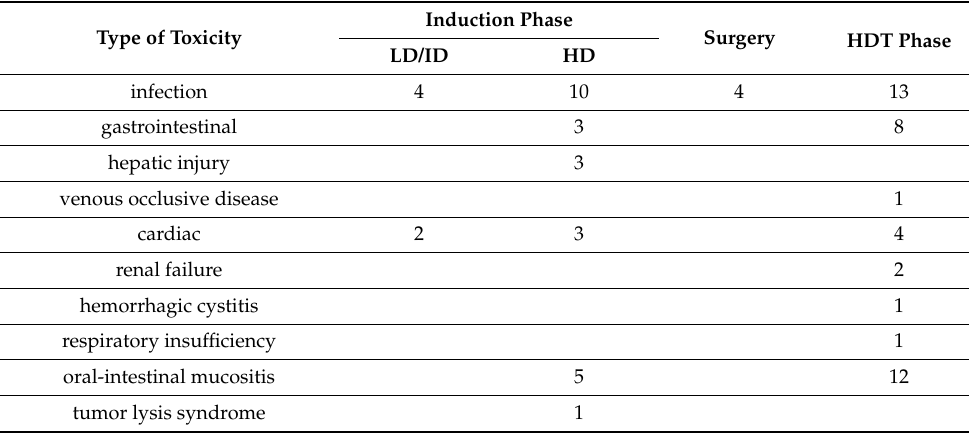
Table A2. Summary of acute treatment-related